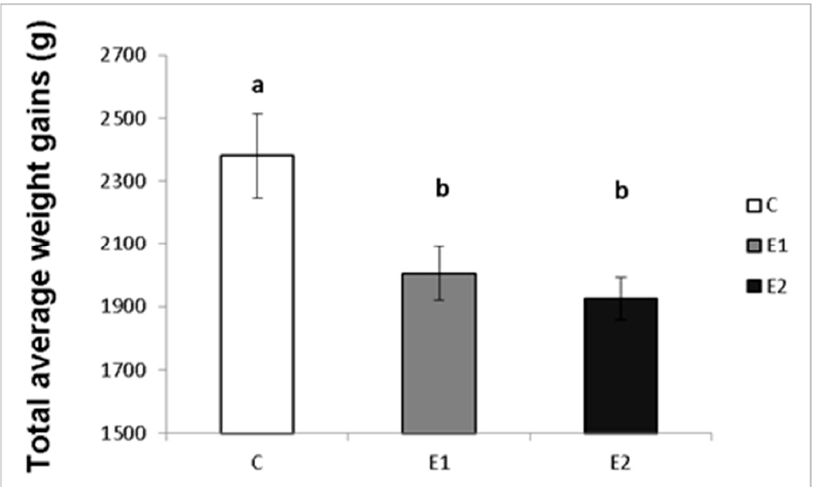
Figure 3. Total average weight gains (g) of male rabbits fed with green tea plant supplemented into complete feed mixture. C (without dietary green tea). E1—5 g green tea/100 kg normal food. E2—20 g green tea/100 kg normal food. Values and error bars express means ± SEM. a vs. b—difference is significant at p <